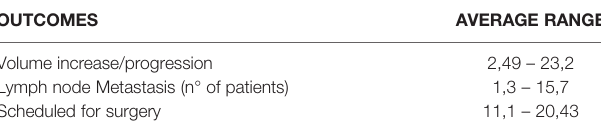
TABLE 2 | Average range of the main outcomes of active surveillance.